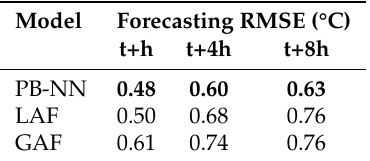
Table 2. Forecasting experiment for several prediction time steps.